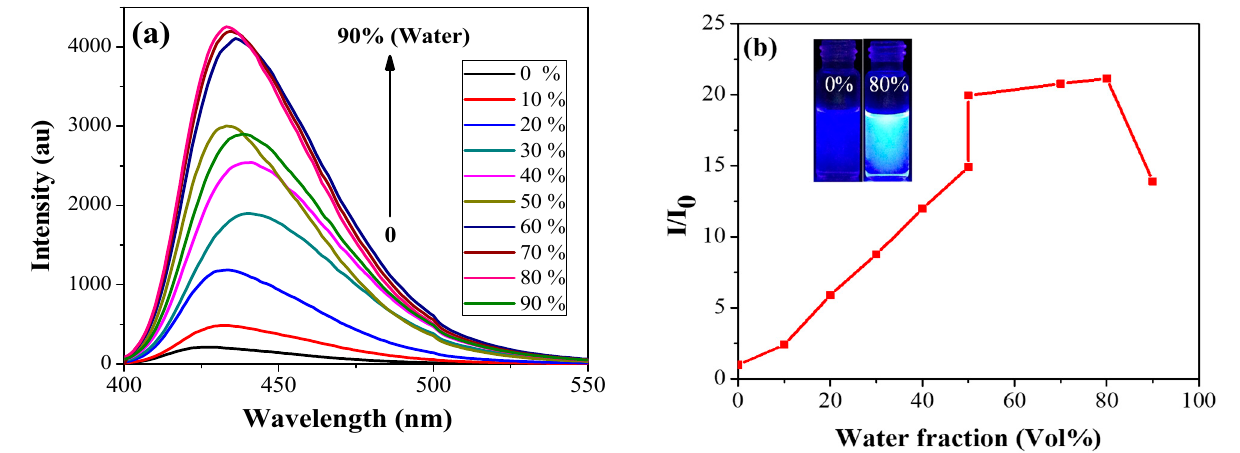
Figure 2. ( a ) PL spectra of compound L (10 µ M) in EtOH with increasing water ratios (0–90%) at λ ex = 380 nm with excitation slit = 5 nm and emission slit = 5 nm. [Note: fluorescence spectra were recorded after 22 h]. ( b ) Plot of relative fluorescence intensity (I/I 0 ) of compound L at 433 nm as a function of the composition of EtOH–water mixture of L; inset: fluorescence photograph of L in EtOH with 0% and 80% of water under 365 nm UV illumination from a hand-held UV lamp after 22 h.